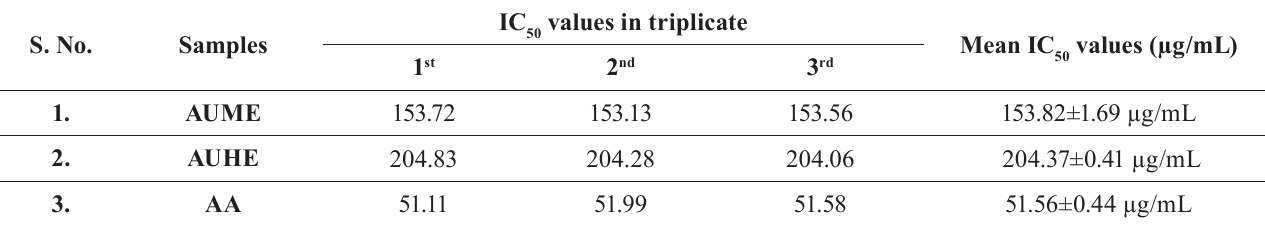
TABLE III - IC of DPPH free radical scavenging activity plant extracts of whole plant of A. uliginosa 50